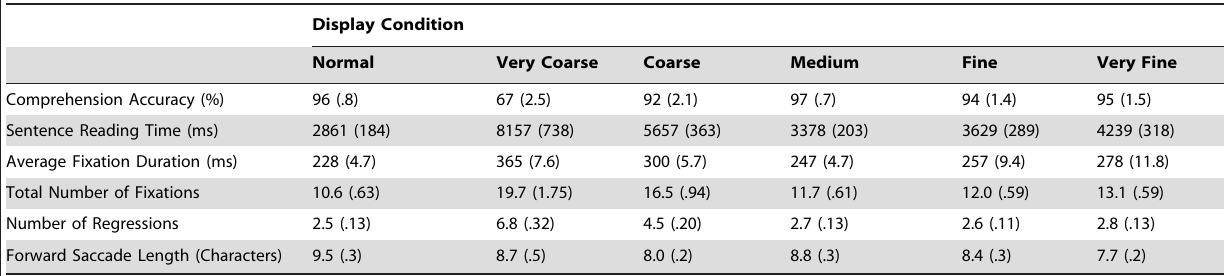
Table 1. Eye Movement Measures for Each Display